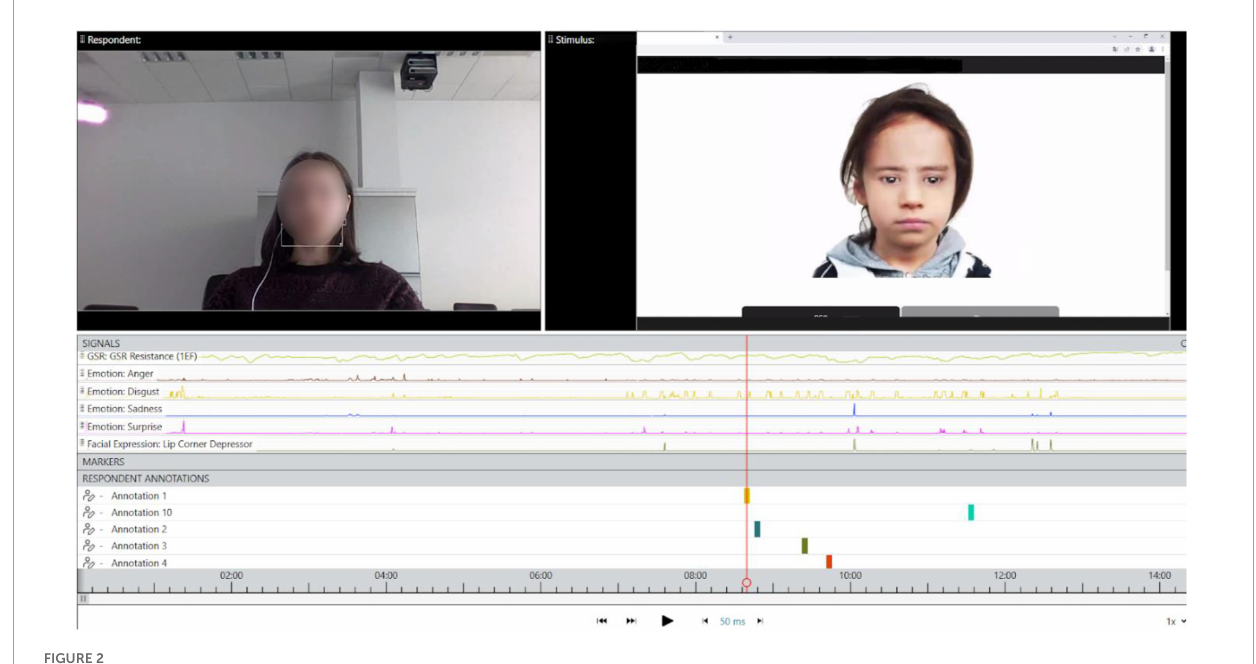
FIGURE2 Coding of closed and open questions preceding a confirmatory